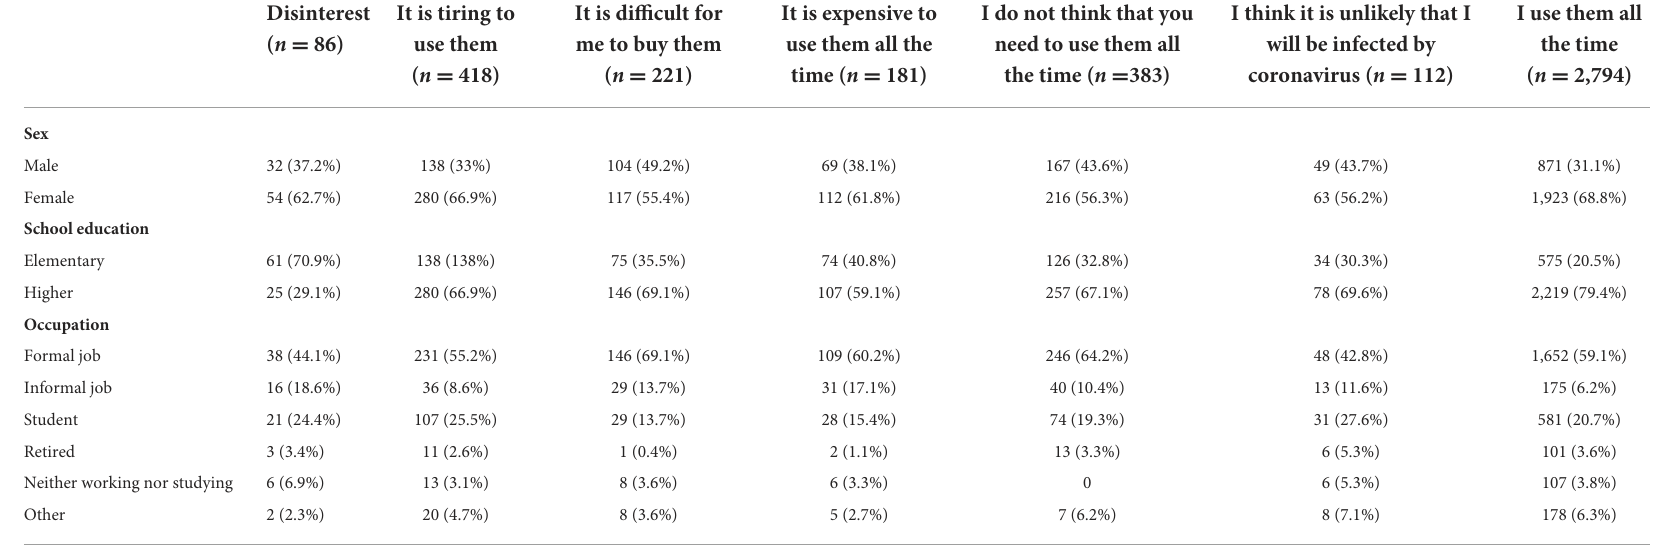
TABLE 3 Reasons why our sample did or did not use preventive measures against